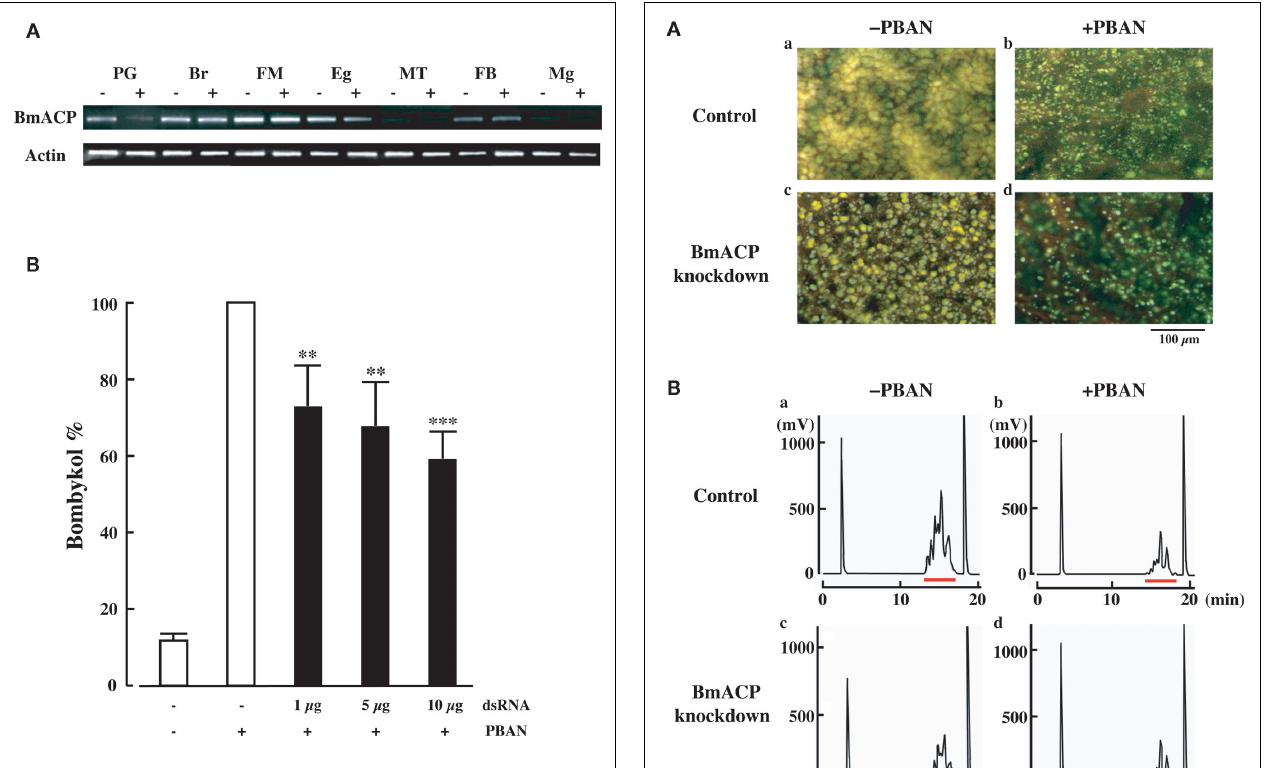
FIGURE 5 | Effect of RNAi treatment on in vivo bombykol production. (A) RNAi-induced suppression of BmACP transcripts. RT-PCR was performed using cDNAs generated from total RNA prepared from pupae injected with 0 μ g ( − ) or 5 μ g ( + ) dsRNAs for BmACP .Tissues were dissected from newly emerged (day 0) p50 female moths: PG, pheromone gland; Br, brain; FM, flight muscle; Eg, unfertilized egg; MT, Malpighian tubule; FB, fat body; Mg, midgut. (B) Effect of RNAi treatment on in vivo bombykol production. Newly emerged female moths were injected with 1, 5, and 10 μ g dsRNA for BmACP . Results are expressed relative to the mean value for bombykol levels in non-RNAi-treated females following injection with 5pmol PBAN (** p < 0.01; *** p < 0.001). Bars represent mean values ± SD from independent experimental animals ( n = > 12).